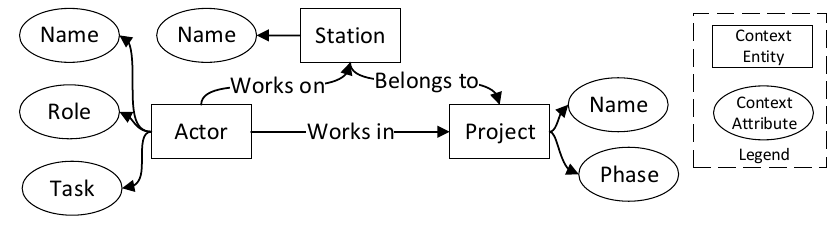
Figure 2. Our context model